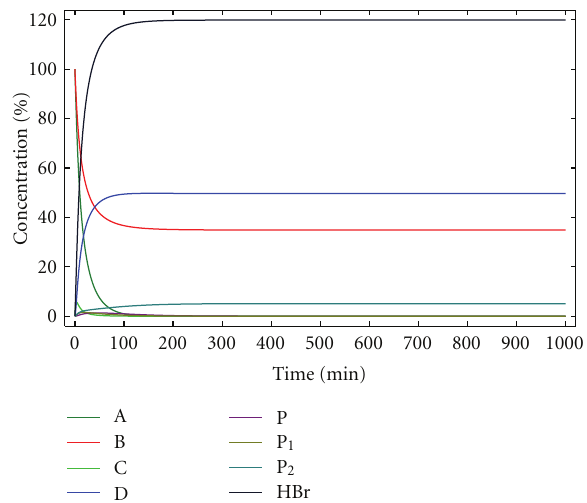
Figure 11: Concentration of the reactants, products, and reac- tion intermediates versus time for kinetic model 6. [A] 0 = [B] 0 = 0.005 M, [Br − ] 0 = 0.0025 M, k 1 = 10M − 1 min − 1 , k 1 c = 4000 M − 2 min − 1 , k 2 = 0.5min − 1 , and k 2 c = 200M − 1 min − 1 .